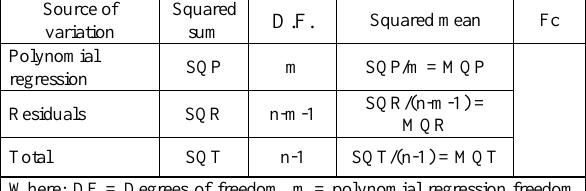
Table 1. Variance analysis table (ANOVA - ANalysis Of